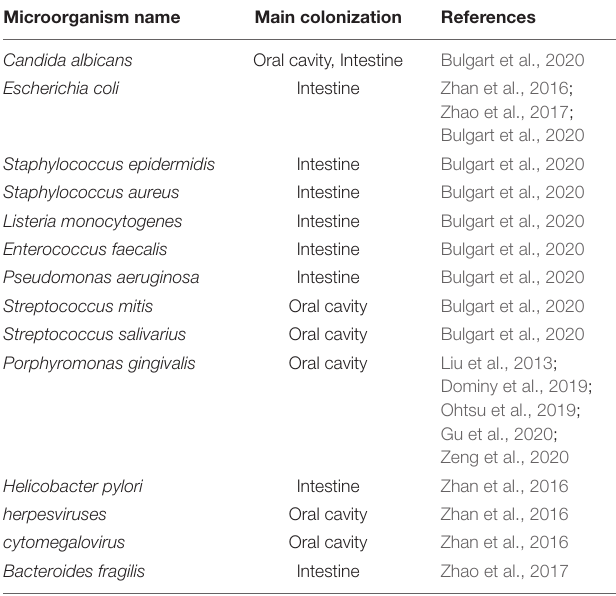
TABLE 1 | Microorganisms associated with AD.